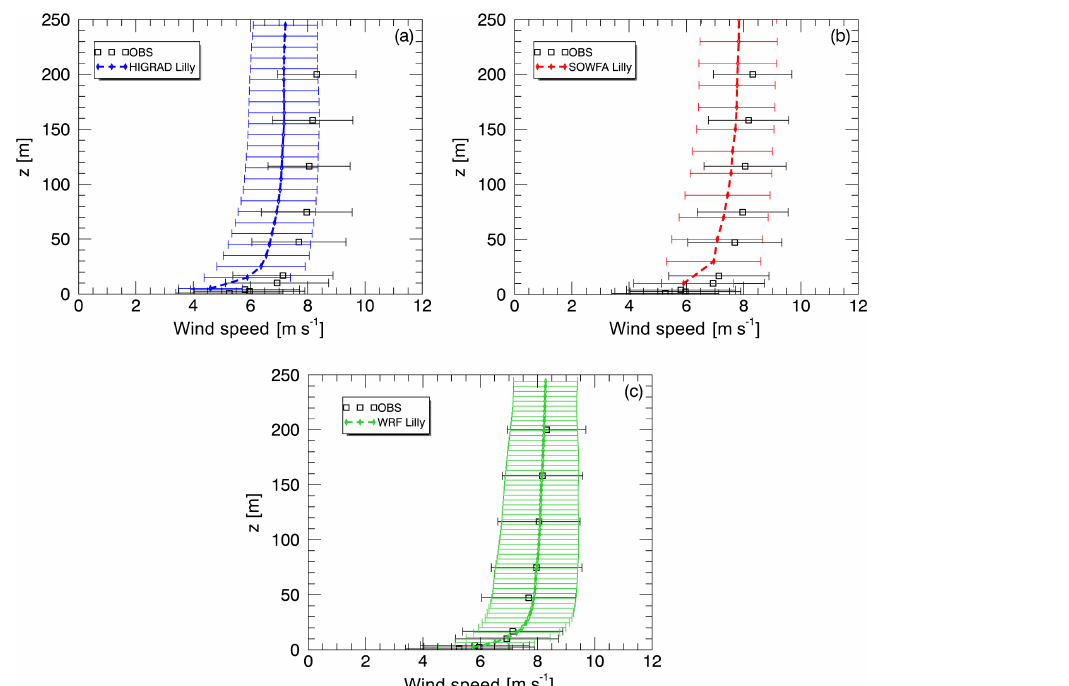
Figure 15. Comparison of variability in observed and simulated wind speed profiles using all three solvers, HiGrad (a) , SOWFA (b) , and WRF (c) , each with its optimal aspect ratio, during the convective case study.